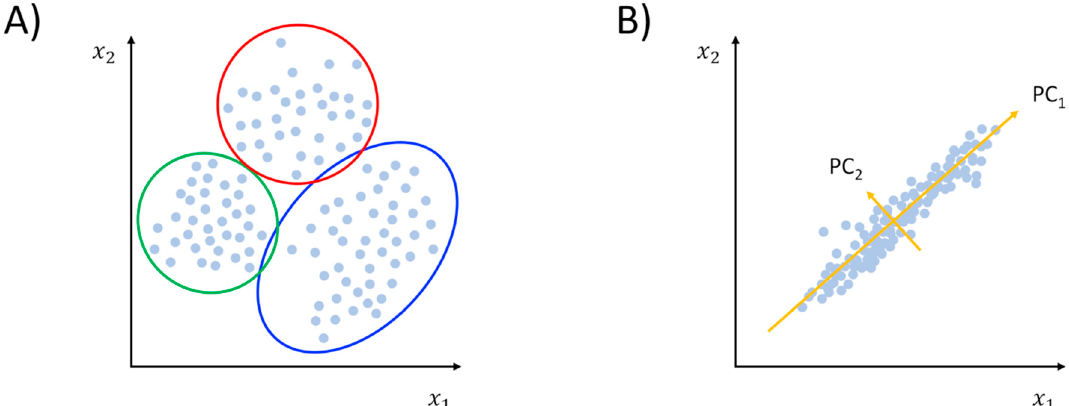
Figure 2. Pictorial representation of the unsupervised learning class of methods: cluster analysis (panel ( A )) and dimensionality reduction (panel ( B ), principal component analysis ( PCA) is displayed as a representative example).